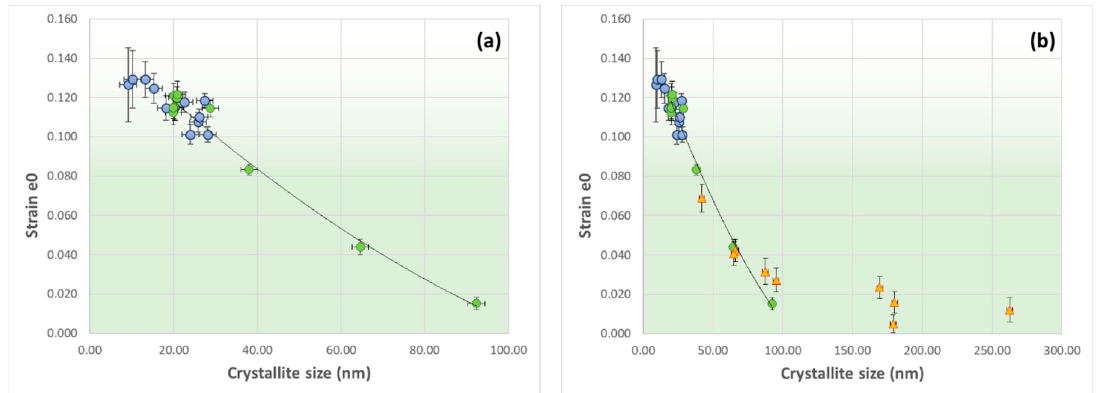
Figure A4. Correlation between crystallite size and microstrain for the aegirine samples of this study. ( a ) detailed view up to 100 nm crystallite size with the data of the low temperature synthesis (blue circles) and the 200 °C-24 h sample, annealed at different temperatures (green circles) ( b ) the same data as in ( a ) but the results for the hydrothermally synthesized samples of [4] are included.